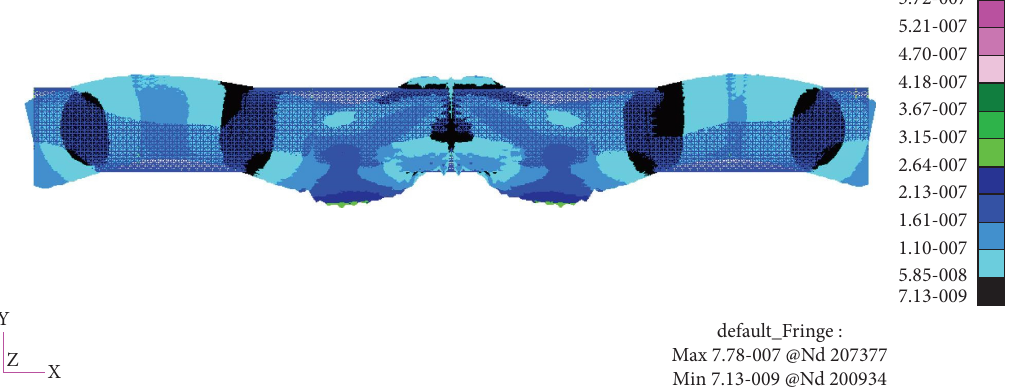
Figure 15: Te response of the structure in vacuum (case